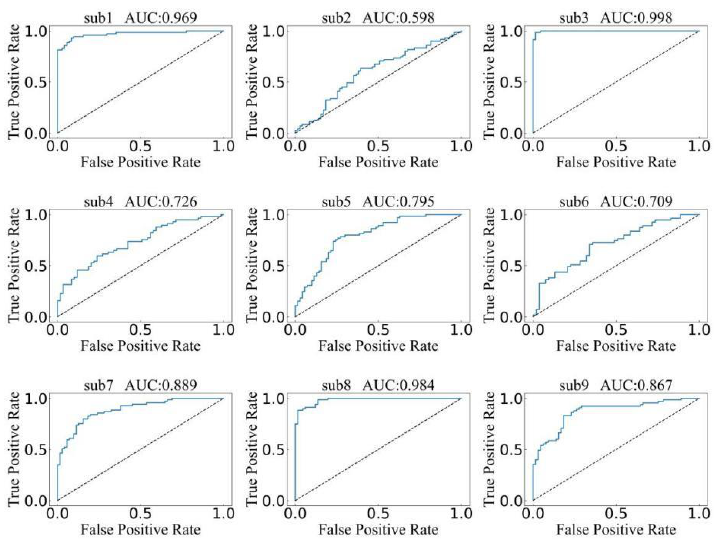
Figure 10. Comparison of ROC curves and the corresponding AUC values on nine subjects using the AS algorithm (The blue curve represents the ROC curve, and the black dotted line is the reference auxiliary line).